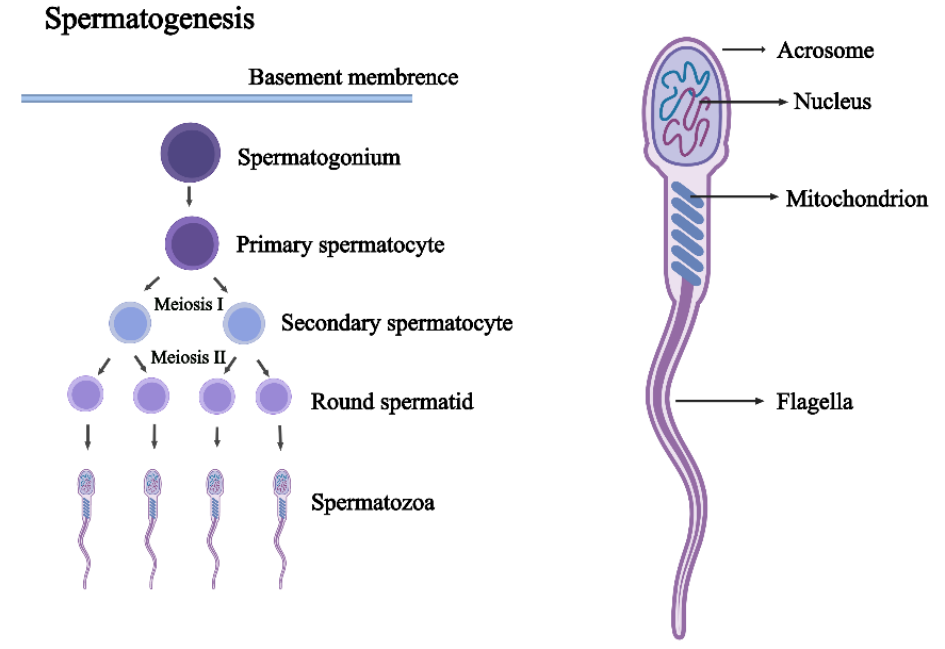
Figure 2. The process of spermatogenesis and the structure of spermatozoa. During spermatogenesis, each diploid primary spermatocyte develops into four haploid round spermatids through meiosis. One primary spermatocyte undergoes a round of DNA replication and meiosis I to produce two haploid secondary spermatocytes. Subsequently, cells proceed through the second cell division stage (meiosis II) to produce four haploid round spermatids. The main structure of spermatozoa consists of an acrosome, nucleus, mitochondrion, and